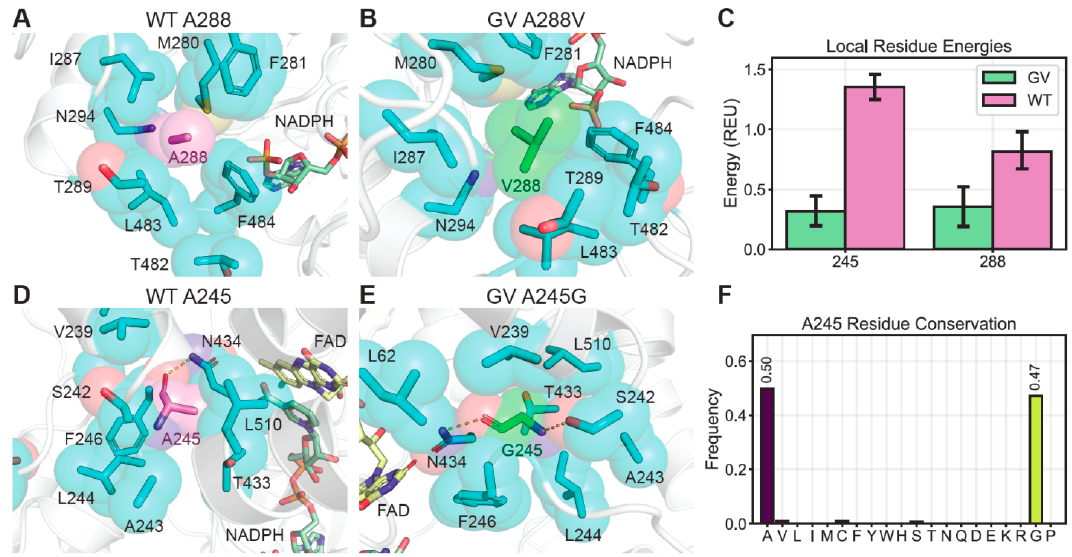
Figure 3. Molecular dynamics (MD) conformational analysis indicates that more optimal residue packing and backbone torsion underlies the increased thermostability of CHMO GV. ( A , B ) At position 288, valine has greater volume and surface area to maximize hydrophobic contact with surrounding residues; ( C ) Rosetta energy evaluation of snapshots from the MD trajectories indicates that interacting residues surrounding the mutated positions experience more favorable contacts in CHMO GV compared to WT; ( D , E ) At position 245, glycine is better enveloped by nearby residues, and has greater backbone torsion freedom to form an additional backbone hydrogen bond. ( F ) Measurement of residue frequencies from sequence alignment of Ac CHMO homologs shows that Ala and Gly are highly conserved at position 245. Values are an average of 200 frames and error bars represent 95% confidence intervals with 1000 bootstrap iterations.